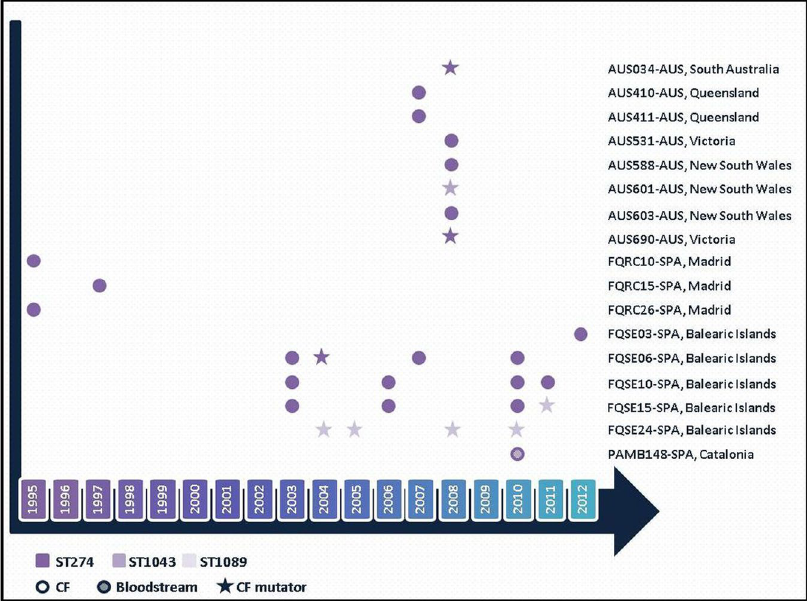
Figure 1. CC274 P . aeruginosa collection. Sampling time from the 29 studied isolates can be inferred from the X axis. Isolates are labelled according to the following format: Patient identification - Country (AUS: Australia; SPA: Spain),